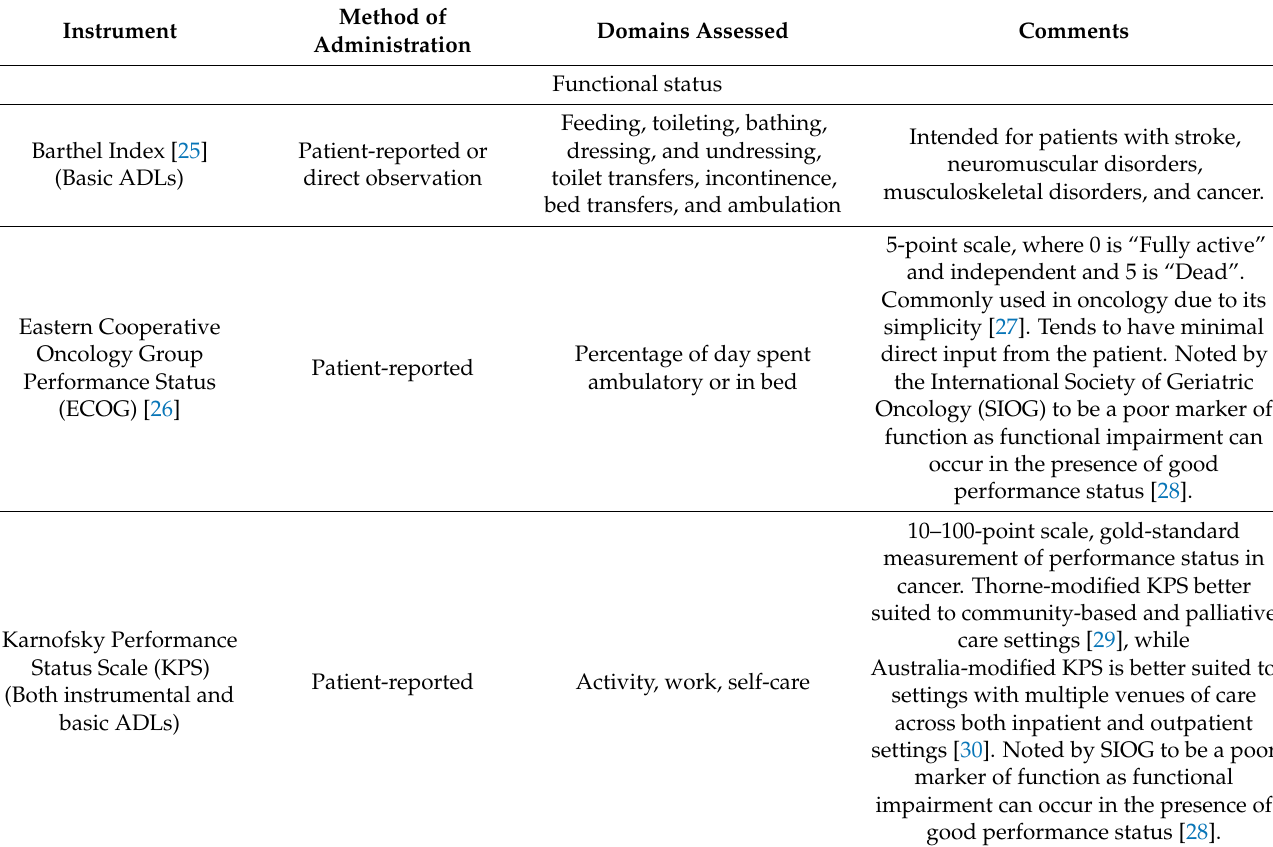
Table 1. Tools that can be used to assess functional status in older patients with